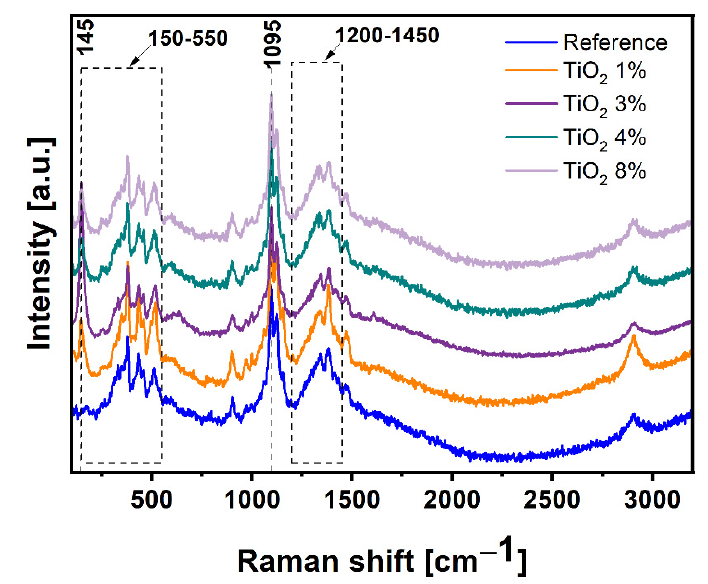
Figure 4. Raman spectra of all samples.